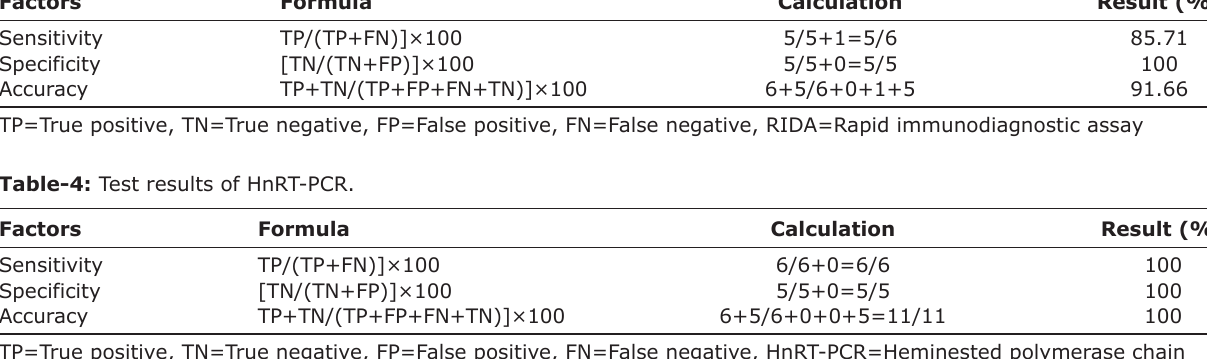
Table-3: Test results of RIDA. Factors